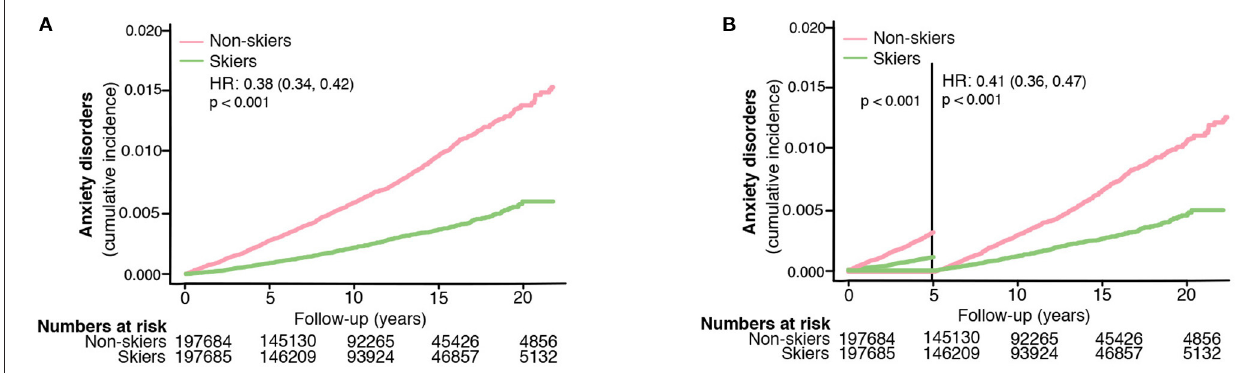
FIGURE 1 | The risk of developing anxiety disorders in skiers compared to non-skiers (A) and the risk of developing anxiety disorders more than 5 years after completing the ski race (B) . HR represents hazard ratios from an unadjusted cox regression.